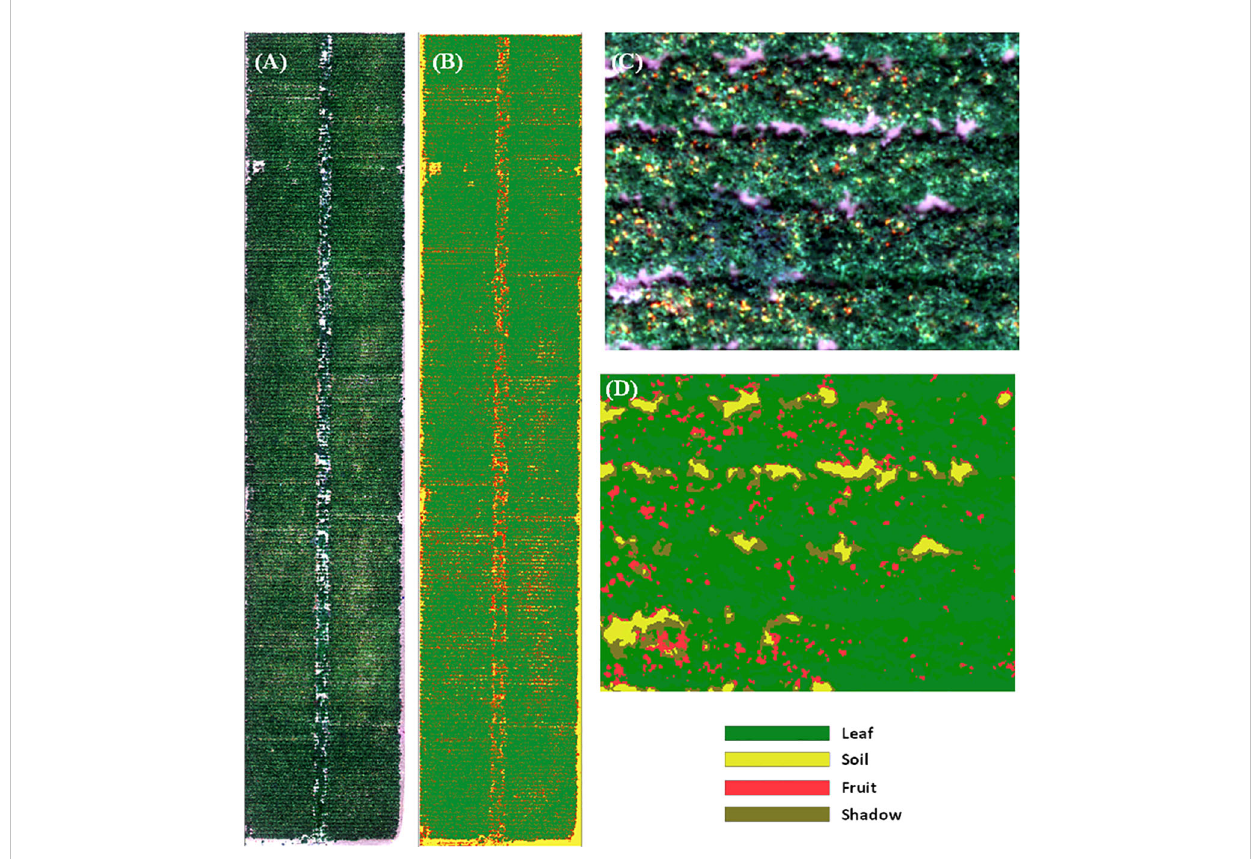
FIGURE 2 RGB imagery of the entire experiment fi eld (A) and a subset of the fi eld (C) . The supervised classi fi cation results of the entire fi eld (B) and a subset of the fi eld (D) based on the unmanned aerial vehicle imagery on August 10, 2019. The imagery was classi fi ed into four categories (leaf, fruit, soil, and